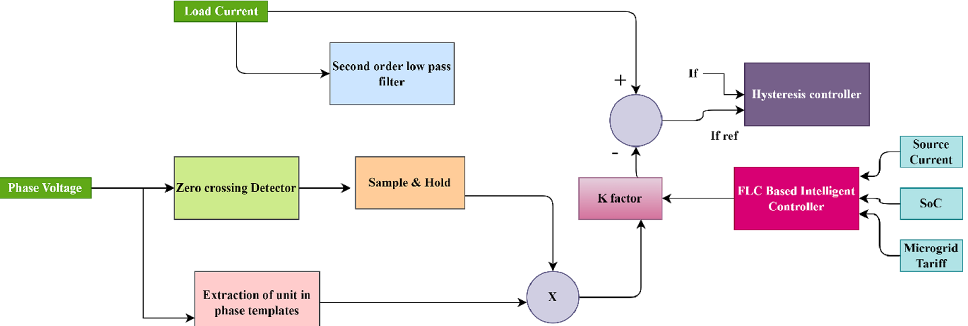
Figure 4. FLC − based intelligent integrated controller with Icos φ control